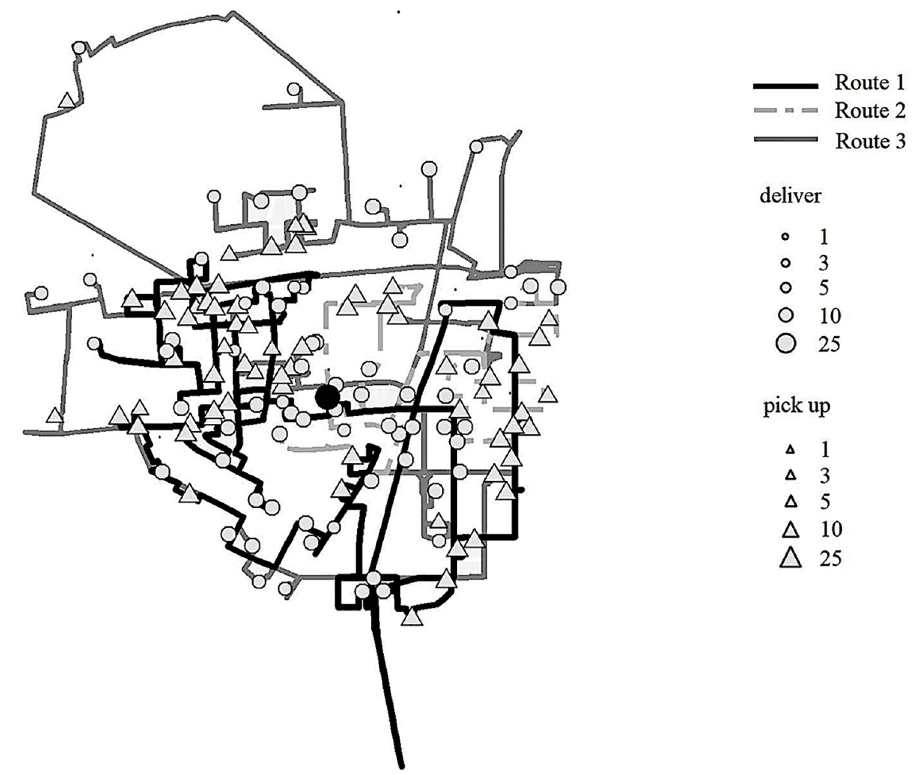
Fig 7. The best-found routes of three vehicles. The black circle marks the depot. The circle in gray represents the station needs bikes to be picked up. The triangle in gray indicates the station needs bikes to be delivered. The best- found routes for three vehicles are shown in different grayscales and line